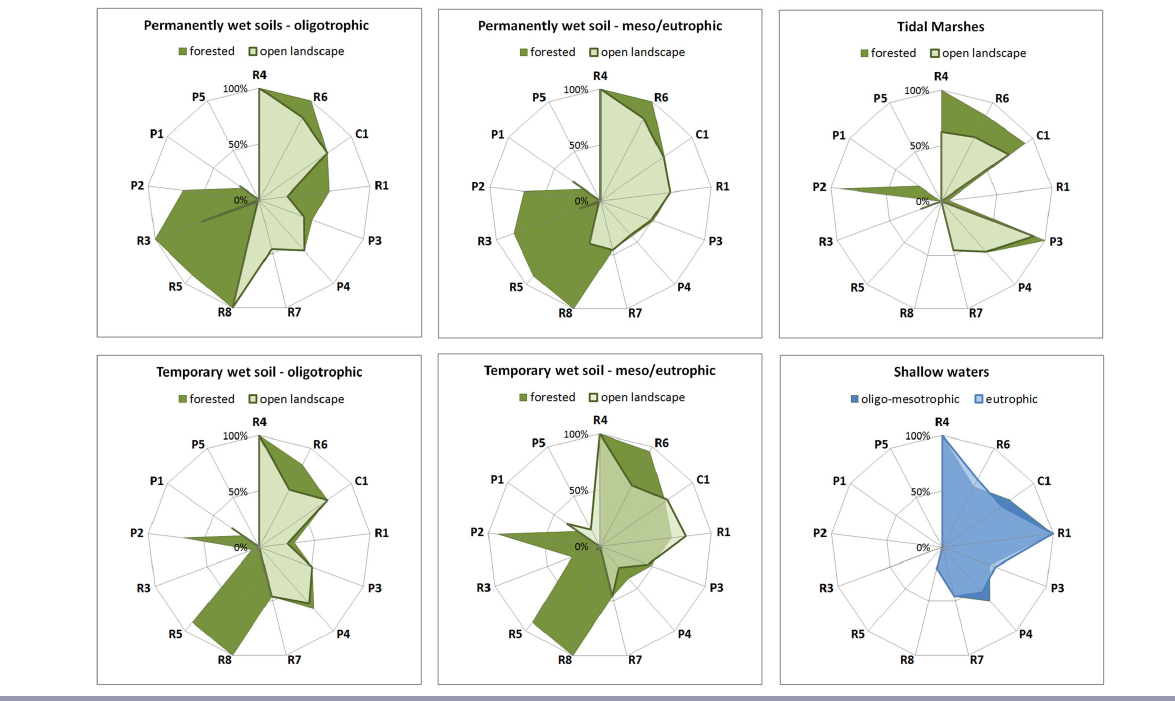
Fig. 1 . Ecosystem service profiles for different wetland-type categories in Flanders. Scores are derived as the median of normalized ecosystem service supply from the Flanders Regional Ecosystem Assessment supply maps (Jacobs et al. 2014 a, 2016 b, Stevens et al. 2015). For instance, in permanent wet, oligotrophic, nonforested habitats (upper left panel), the pixels of this habitat on the climate regulation supply map of Flanders (R6, normalized from 0-100) have a median score of 80%. Legend: C1 - Cultural Services; R1 - Flood Risk Regulation; R3 - Water Quality Regulation; R4 - Pollination; R5 - Air Quality Regulation; R6 - Climate Regulation ; R7 - Erosion Risk Regulation; R8 - Sound buffer; P1 - Energy Crop Production; P2 - Wood Production; P3 - Wild Meat Production; P4 - Ground Water production; P5 - Food Production. Details on quantitative units are depicted in Table